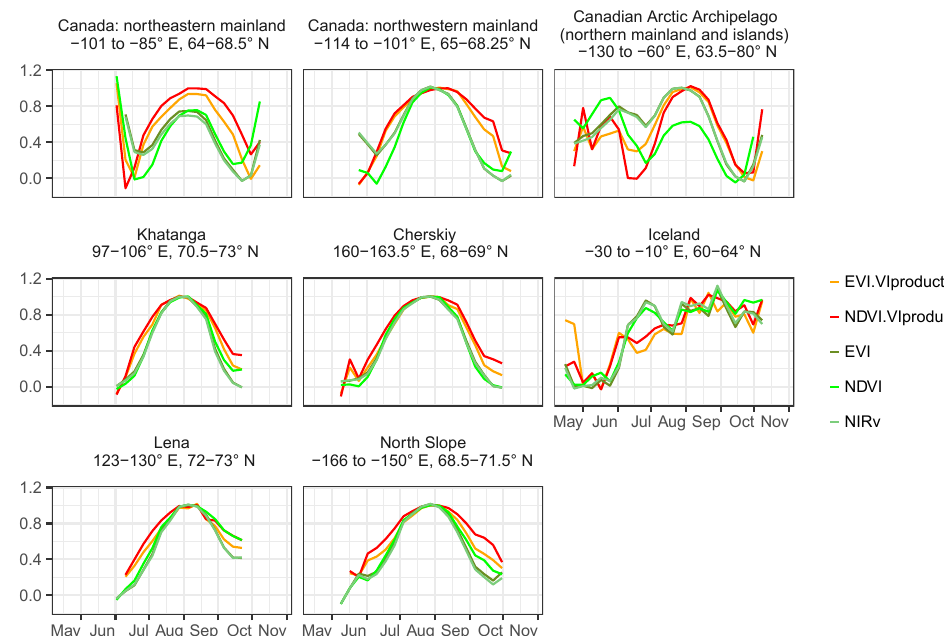
Figure A18. Mean seasonal cycles of MODIS vegetation indices calculated from NBAR reflectances (MCD43C4) and as provided by the MODIS VIproduct (MxD13C1). Values are scaled to 0 / 1.